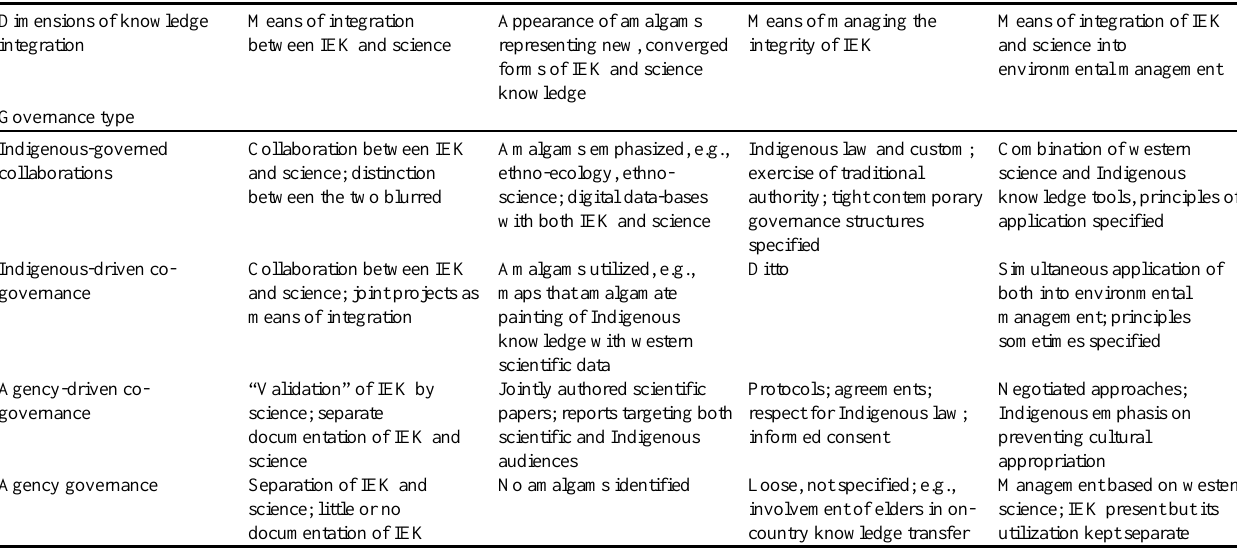
Table 4 . Analysis of manifestations of Indigenous Ecological Knowledge (IEK) and science integration according to governance